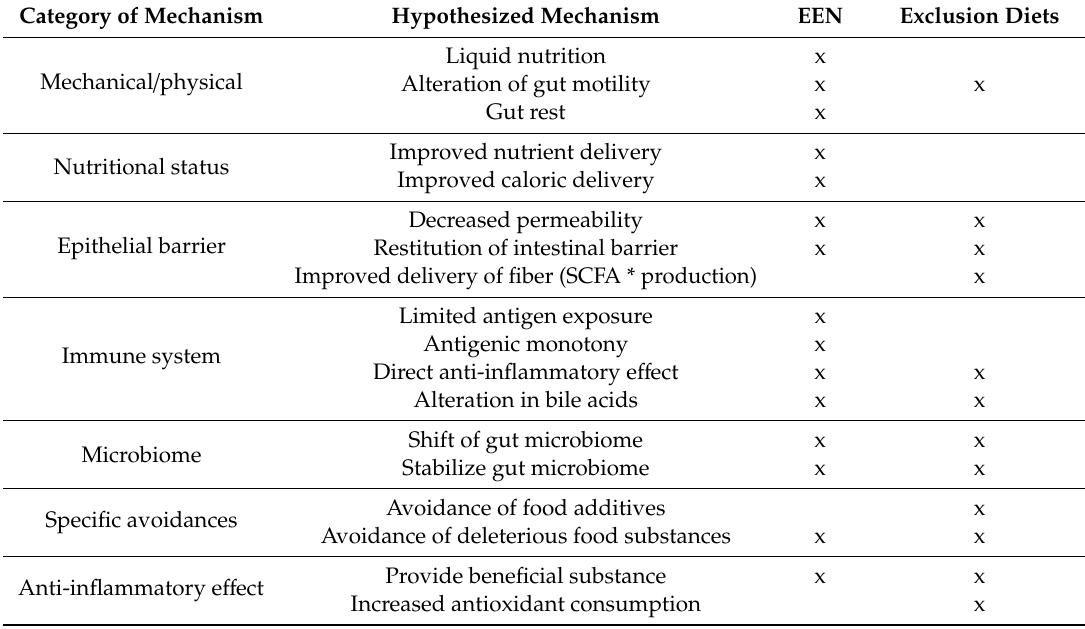
Table 1. Hypothesized Mechanisms of Action for Diet Therapy in Inflammatory Bowel Disease (IBD). Category of